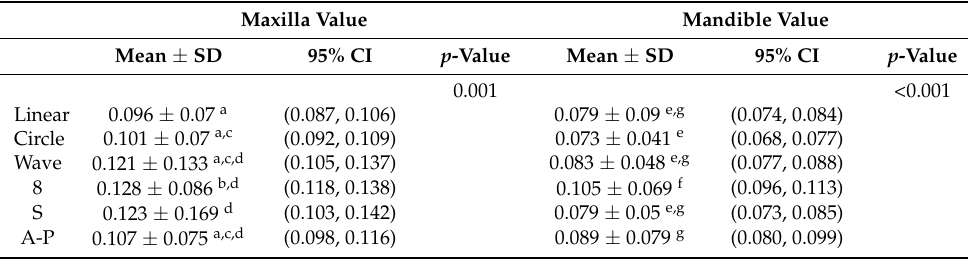
Table 3. Mean absolute deviations of maxilla and mandible (mm). Maxilla Value Mandible Value